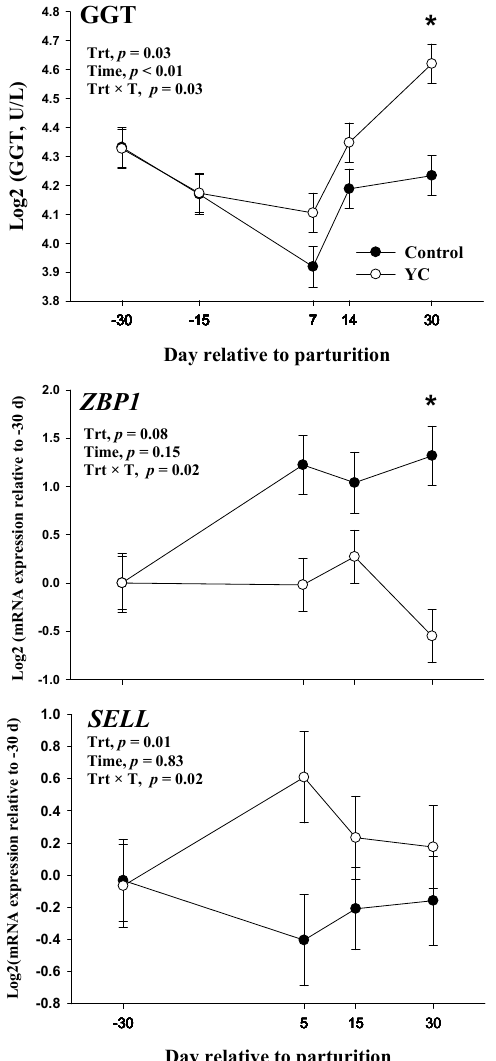
Figure 1. Blood gamma-glutamyl transferase (GGT) and gene expression of Z-DNA binding protein 1 ( ZBP1 ) and L-selectin ( SELL ) in polymorphonuclear leukocytes in cows ( n = 8/treatment) supple- mented with a basal diet (Control) or a basal diet plus yeast culture fermentation production (YC) from − 31 ± 6 d relative to parturition through 50 DIM. Mean separations between treatments at a given time point were evaluated when a treatment × time (Trt × T) interaction ( p ≤ 0.05) was ob- served, and differences (*) were declared at a Tukey-adjusted p ≤ 0.05. Values are means, and SE are represented by vertical bars.